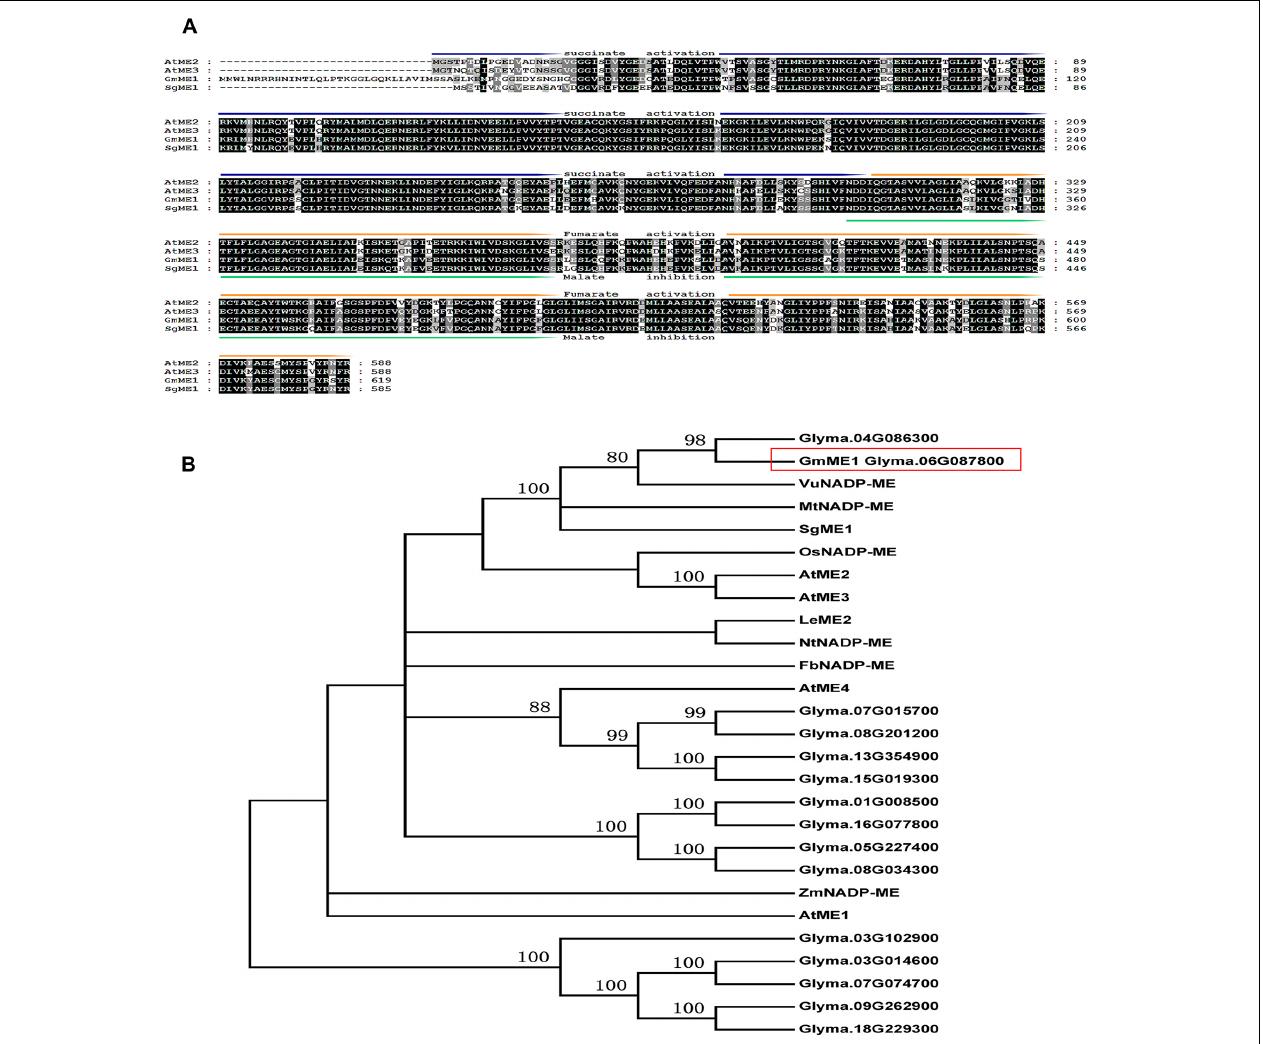
FIGURE 4 | Sequence (A) and phylogenetic tree (B) analysis of GmME1 and other known plant NADP-Malic enzymes. (A) Alignment of the amino acid sequences of GmME1 and orthologous proteins from other plant species, including AtME2 (GeneID:831039), AtME3 (GeneID:832657) and SgME1 (LOCUS AGH32501). Regions of the primary structure of each isoenzyme are labeled as follows: fumarate activation (orange), malate inhibition (green), and succinate activation of the reverse reaction (blue). (B) Phylogenetic relationship of GmME1 and other known Malic enzymes proteins. Arabidopsis thaliana ( AtNADP-ME1 GeneID:816509, AtNADP-ME2 GeneID:831039, AtNADP-ME3 GeneID:832657, AtNADP-ME4 GeneID:844314), Flaveria bidentis ( FbNADP-ME LOCUS: AAW56450), Lycopersicon esculentum (LeME2 LOCUS: AAB58728), Medicago truncatula ( MtNADP-ME GeneID:25490143), Nicotiana sylvestris ( NtNADP-ME GeneID:104247285), Oryza sativa ( OsNADP-ME GeneID:4338007), Stylosanthes guianensis ( SgME1 LOCUS AGH32501), Vigna umbellata ( VuNADP-ME LOCUS CAA56354), Zea mays ( ZmNADP-ME GeneID:542209) 1 LOCUS AGH32501) and GmME1 Glyma.06G087800